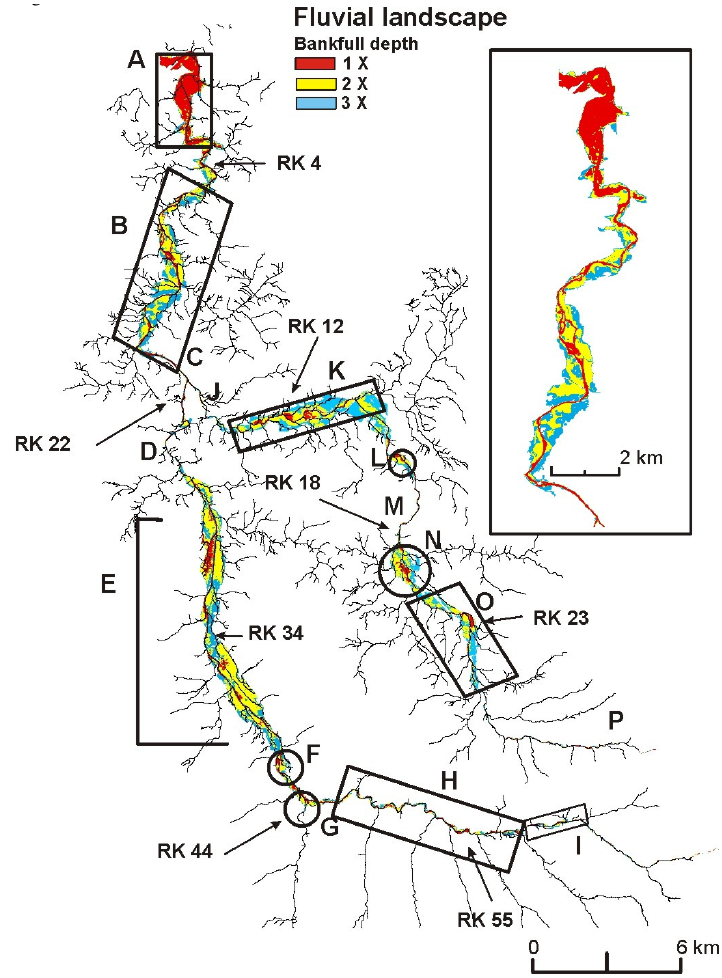
Fig. 4. The stream network (channels with gradients less than 10%) and the predicted fluvial landscape are shown for the Pas River catchment in association with elevations above the channel equivalent to one, two and three bankfull depths. Sites A–I correspond to locations indicated in Fig. 3 and sites J through P are shown in Fig. 8. The inset box is an enlargement of the fluvial landscape in “A” and “B” and the intervening